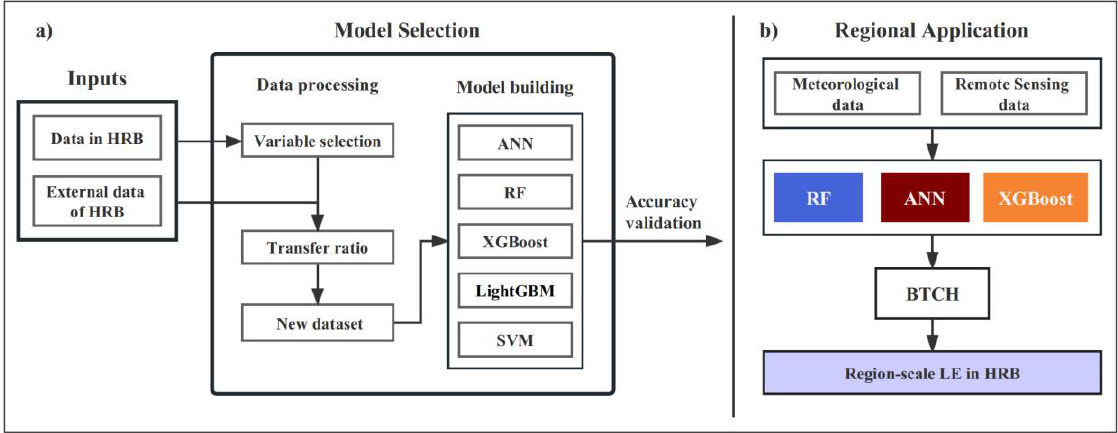
Figure 2. The latent heat flux upscaling model framework. ( a ) Building and screening of transfer learning models. ( b ) Regional application of the fusion model based on the BTCH method.